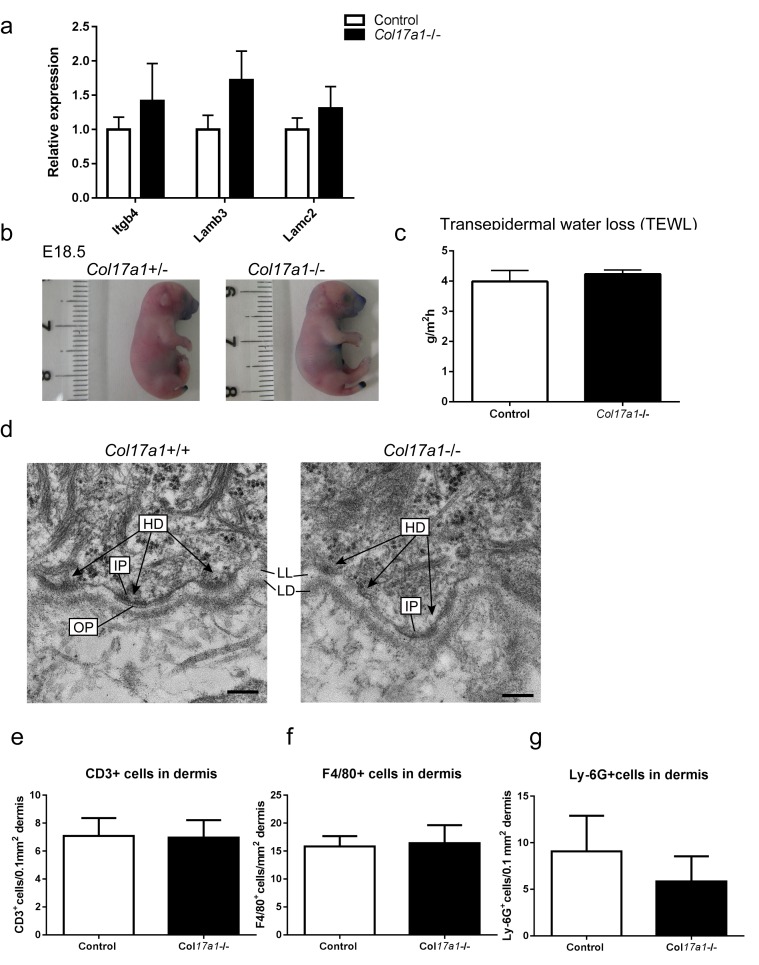
Barrier function assay of Col17a1−/− and littermate controls (E18.5).Inflammatory cell infiltration in the dermis of Col17a1−/− and littermate controls (P1) and ultrastructural findings of the basement membrane zone in the paw epidermis of Col17a1−/− and littermate controls (P1). (a) mRNA expression levels of Itgb4, Lamb3 and Lamc3 (n = 4). (b) Dye permeabilization with Toluidine blue (representative images from three Col17a1−/− mice and eight control mice). (c) Transepidermal water loss (TEWL) (n = 3 for Col17a1−/− mice; n = 8 for control). (d) In the Col17a1−/− paw epidermis, hemidesmosomes (HD) comprising inner plaques (IP), outer plaques (OP) and anchoring fibrils were blurred compared with those of the Col17a1-/- mice. LL: Lamina Lucida, LD: Lamina densa. Scale bar = 0.2 μm. Representative images from two mice. (eg) Quantification of immune cells in the paw skin dermis of Col17a1−/− and control mice (n = 4). The data are the means±SE. *0.01<p<0.05, **0.001<p<0.01, Student’s t-tests.